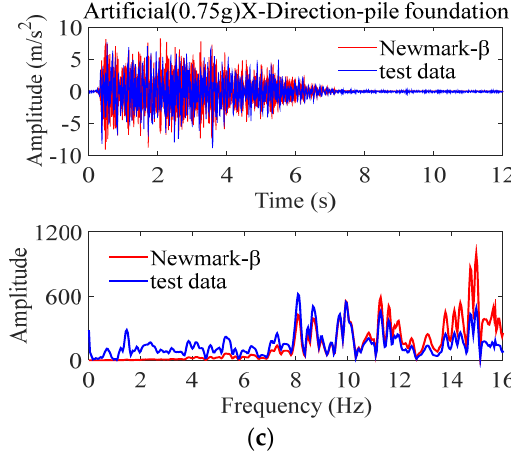
Figure 12. Comparison of shaking table test data and theoretical solution under the artificial wave: ( a ) dome acceleration time history and spectrum comparison; ( b ) cushion cap acceleration time history and spectrum comparison; ( c ) pile foundation acceleration time history and spectrum comparison.